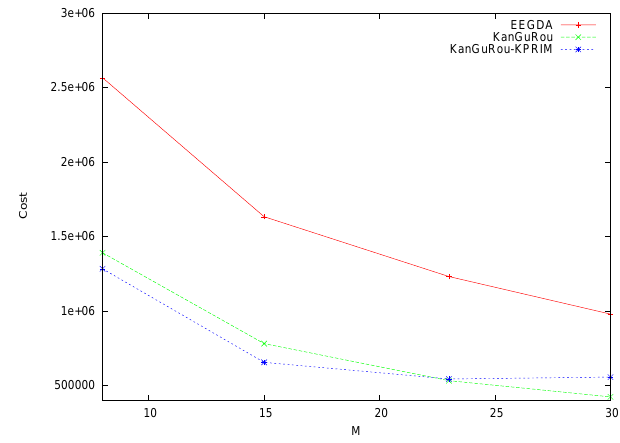
Figure 9. Algorithms performances for k = 5 and N = 75